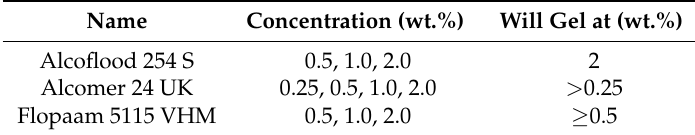
Table 4. Minimum concentration for gel formation for the different polymers with Cr 3+ as the cross-linker.